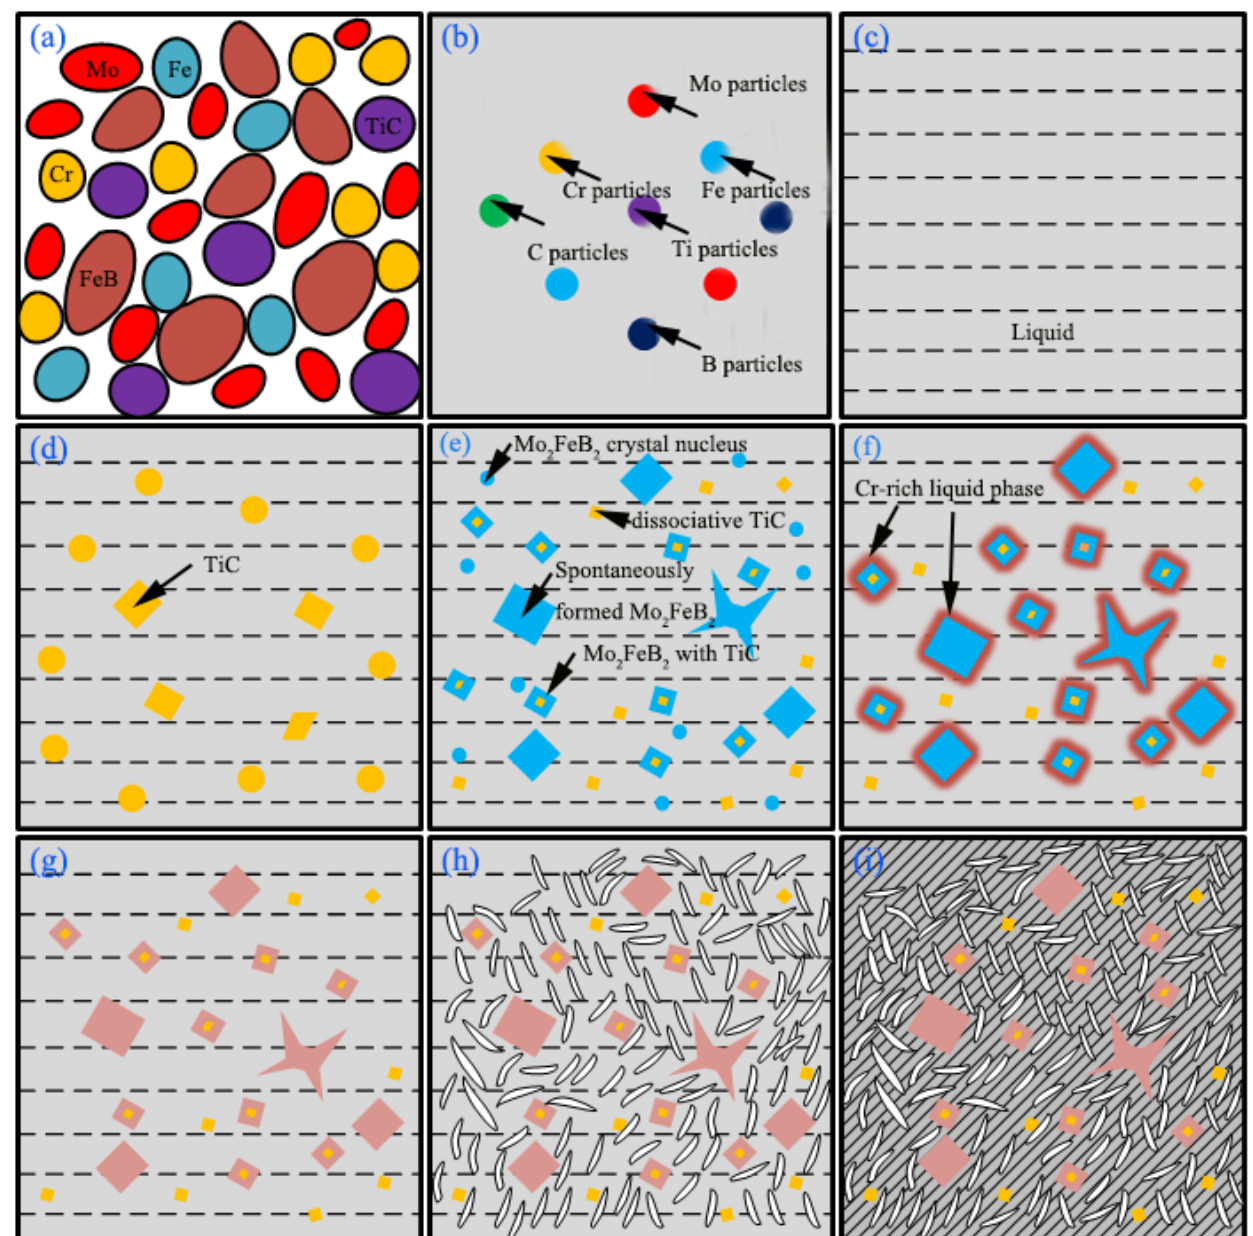
Figure 8. Schematic diagram of the microstructure evolution during the cladding process. ( a ) alloy powder ( b ) forming weldpool ( c ) weldpool ( d ) Nucleation and growth of TiC ( e ) Mo 2 FeB 2 formation ( f ) Cr-rich around Mo 2 FeB 2 ( g ) M 3 B 2 (M:Mo,Fe,Cr) formation ( h ) binary borides formed ( i )